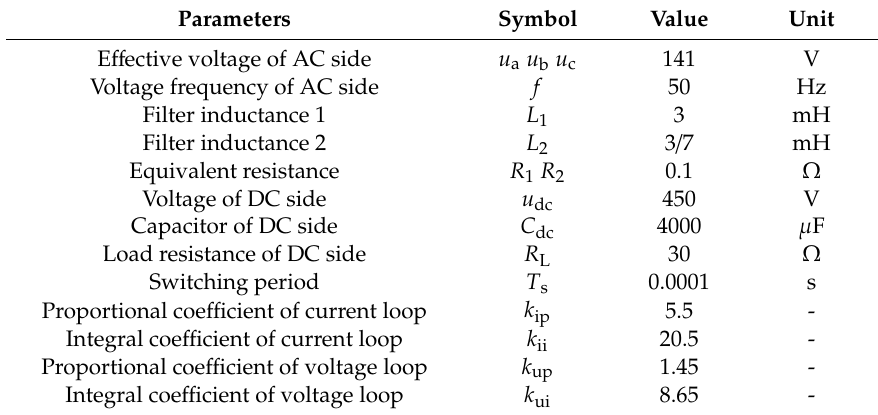
Table 1. Parameters for simulation of paralleled